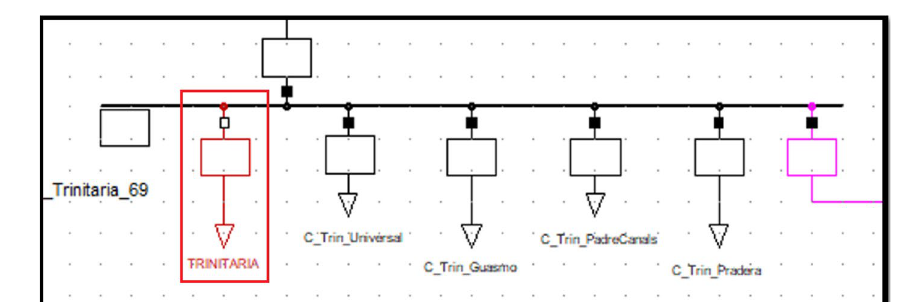
Figure 9. Trinitaria static (general) load model representation.